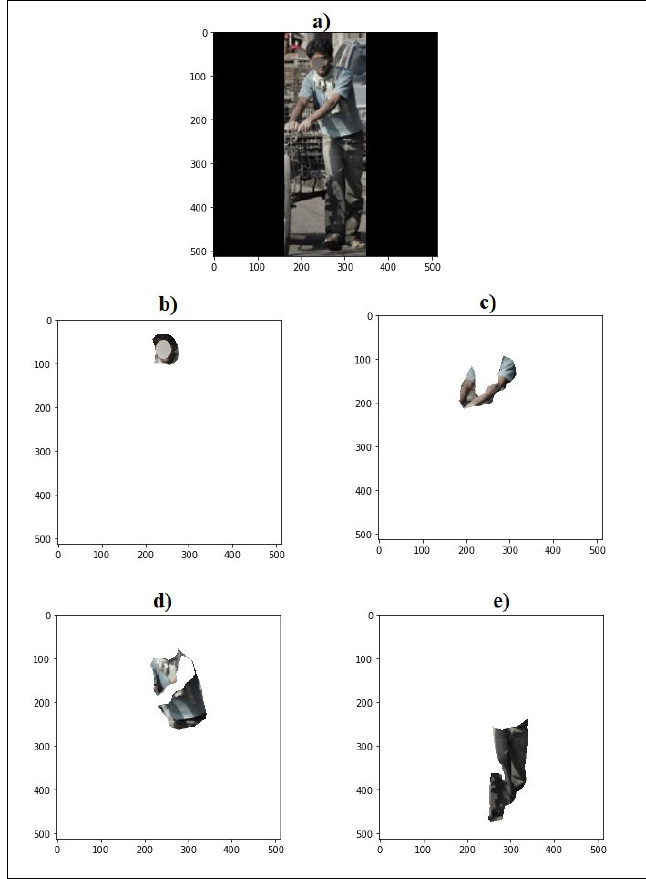
Figure 4. Example of segmentation of human body parts: ( a ) input image, ( b ) face, ( c ) arm, ( d ) torso, and ( e )